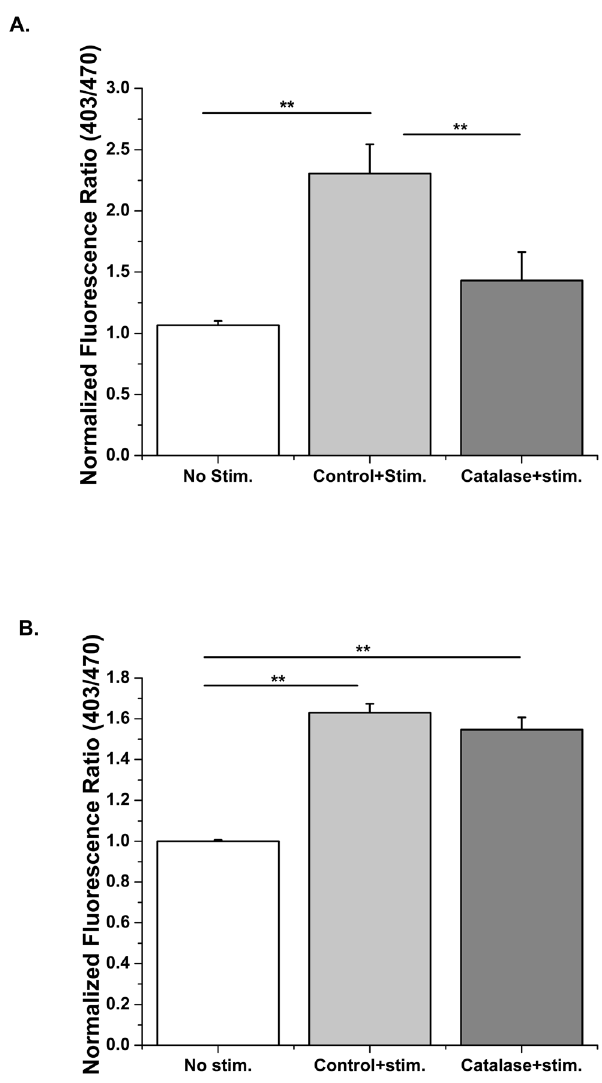
Figure 8. p47-roGFP measures Nox dependent ROS produced in the extracellular space. Catalase (4 m M) in the extracellular space prevented the oxidation of p47-roGFP (A) but did not alter the oxidation of Grx1-roGFP2 (B) during electrical stimulation of FDB myofibers.